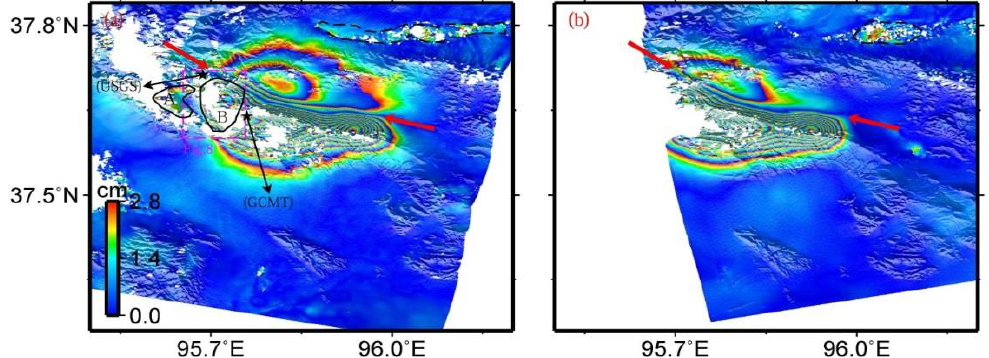
Figure 2. Interferograms of the descending track T319 ( a ) and the ascending track T455 ( b ) for the 2009 Dachaidan Mw 6.3 earthquake. Red arrows point out the deformation boundaries with a South-East-East (SEE) direction between hanging wall and footwall, which are used to determine the fault locations in the inversion step. The deformation zone labeled as A and delimited by the black polygon in ( a ), isolated from the deformation zone B, may result from atmospheric errors and/or aftershocks. The dashed purple rectangle in ( a ) is the spatial extent of Figure 8. The dashed black polygons in ( a , b ) delimit the zones that mainly include contribution from atmospheric errors, DEM errors, and other unknown errors. Epicenters of the main shock from GCMT and USGS catalogues are displayed in ( a